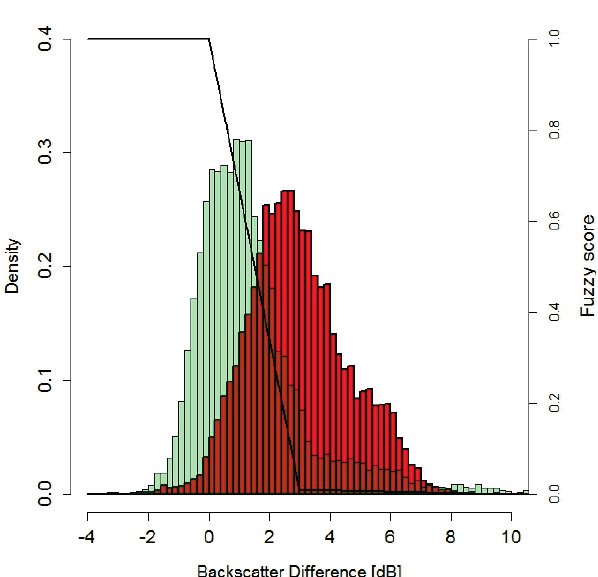
Figure 5. The histograms of ∆σ ° values over burned (red) and unburned (green) surfaces (unburned vegetation, soil/sparse vegetation and urban all together) shown as probability density. On the secondary y-axis the score given by the membership function of fuzzy sets ( μ ∆σ ° for the negative evidence as defined by Equation